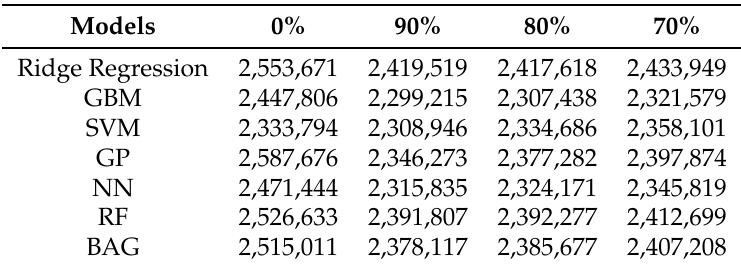
Table 2. The performances of various outlier detection methods are measured by the MAE in Wh/m 2 . The numbers represent the percentage of ourliers